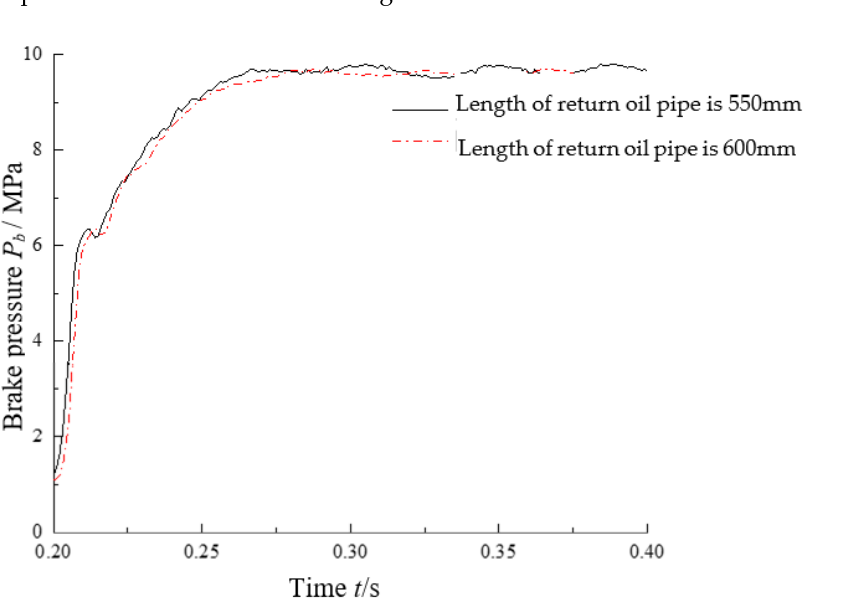
Figure 21. The experimental results of brake pressure with different hydraulic hoses. Table 5. The sensitivity index